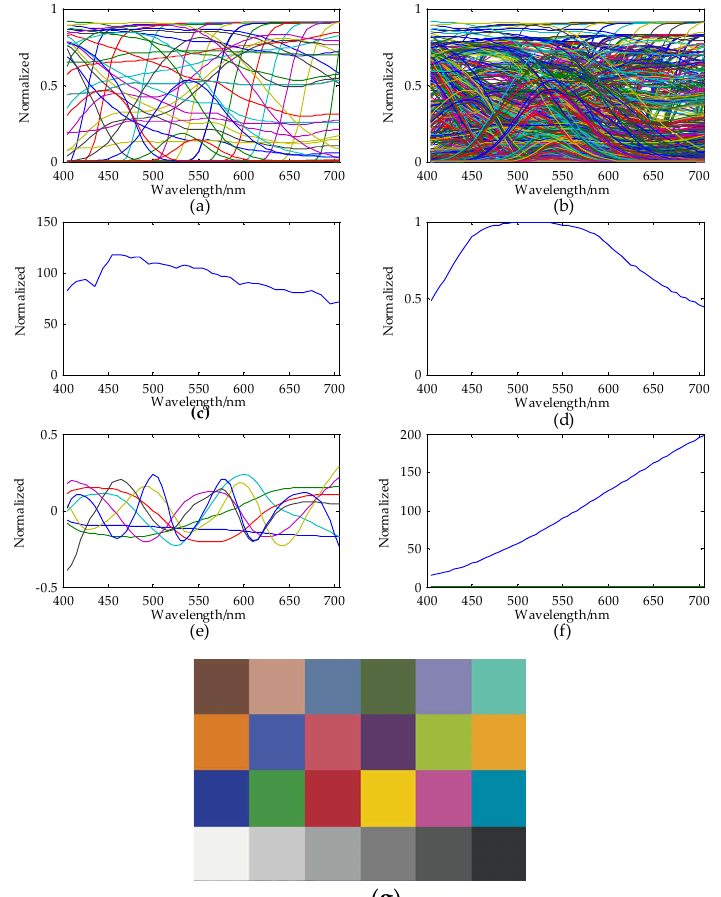
Figure 1. The data sets used for simulation are visualized above: ( a ) transmittances of 45 single filters; ( b ) all 1035 transmittances of single filters and two single filter combinations; ( c ) camera sensitivity of a Basler 302f camera sensor; ( d ) CIE standard illuminant D65; ( e ) The first eigenvectors of spectral data of the Macbeth ColorChecker; ( f ) CIE standard illuminant A and ( g ) color display of spectral data cubic of the Macbeth Color Checker.